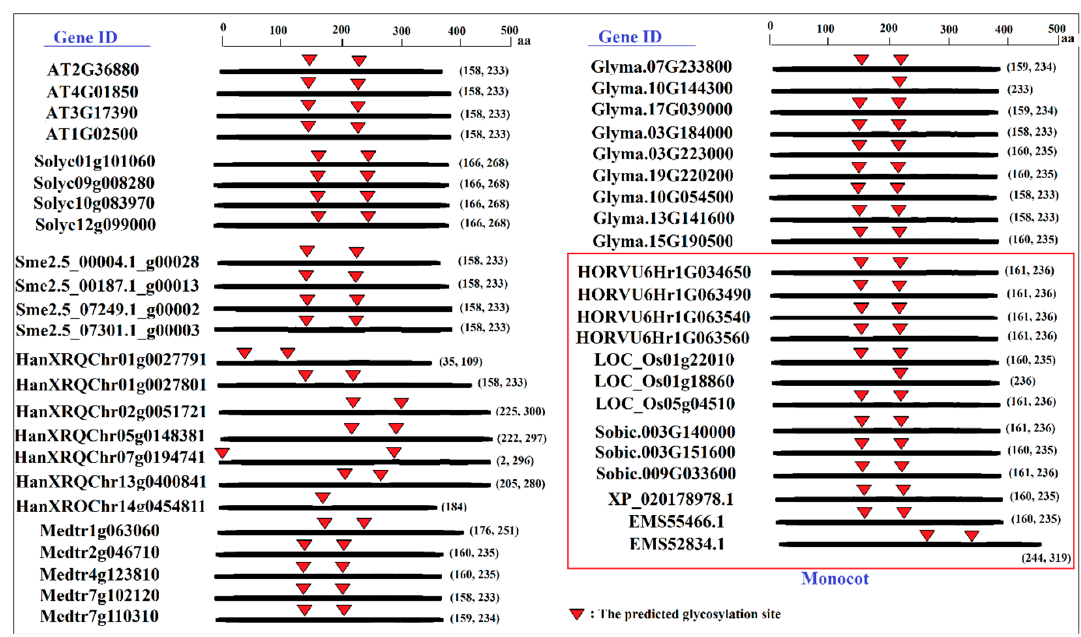
Figure 4. Predicted phosphorylation sites of SAMS proteins in different plant species determined using the NetPhos 3.1 server.